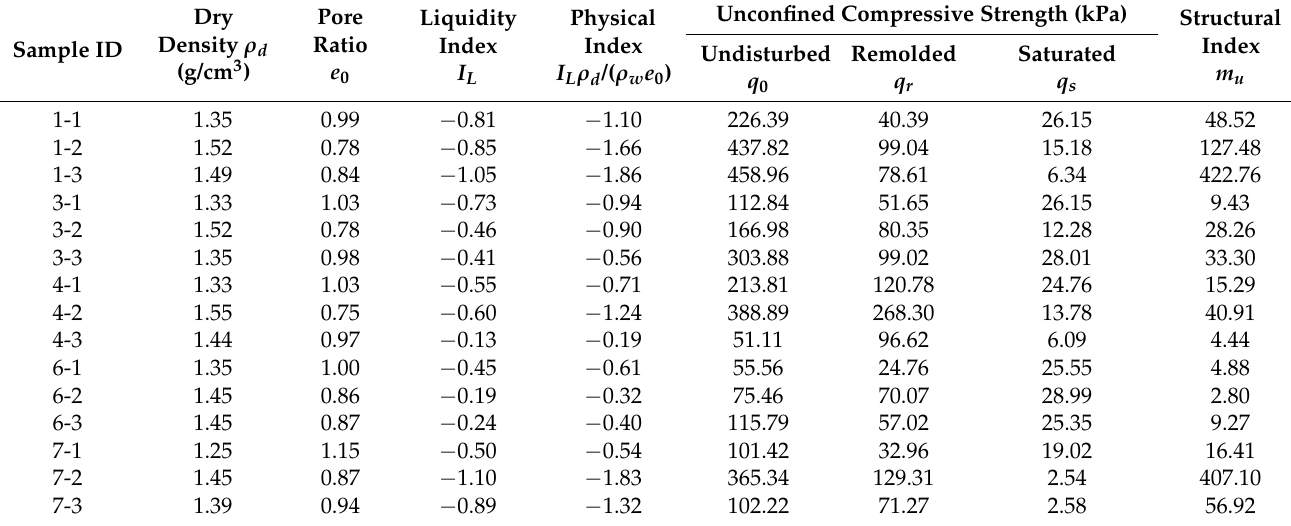
Table 1. Physical indicators obtained from laboratory tests and the calculated soil structure index of the collected loess